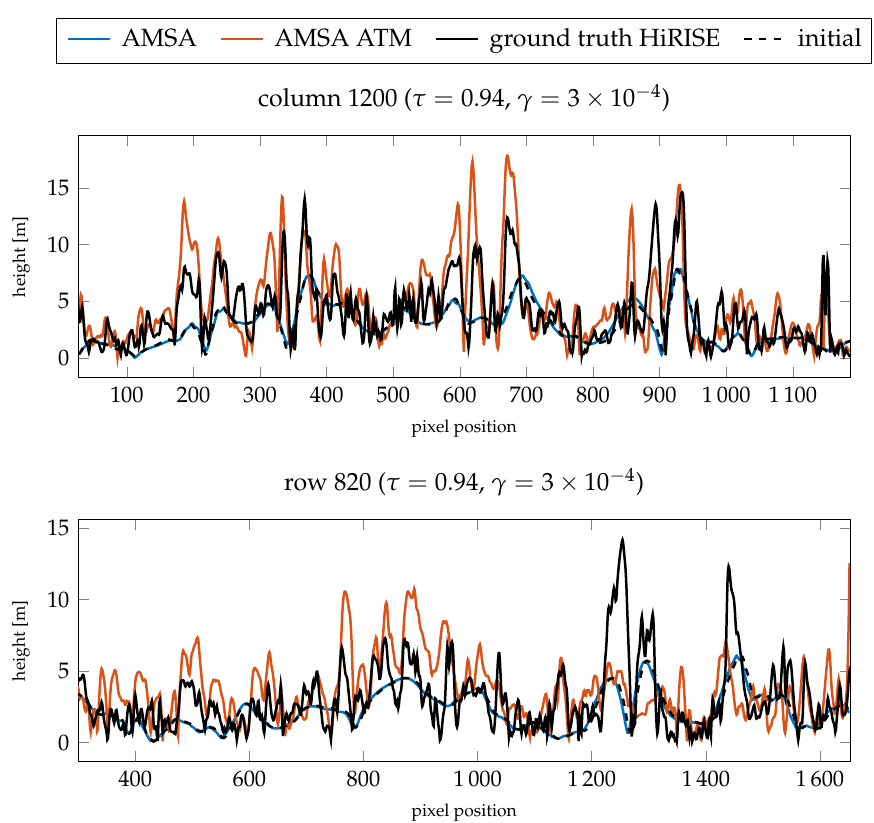
Figure A5. Slopes for image K13_058475_2232_XN_43N103W (bad atmospheric conditions) not displayed in the main